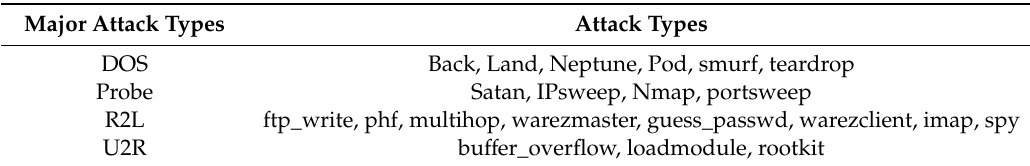
Table 1. Attack types on Train + 20%.